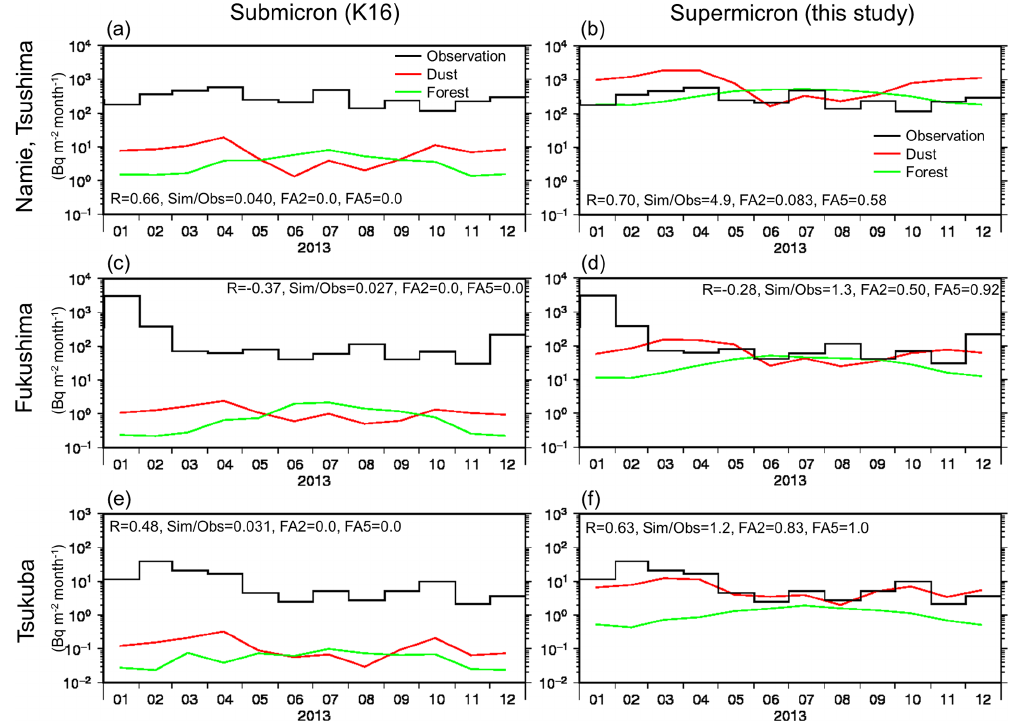
Figure 3. Monthly deposition amounts of (black) observed 137 Cs and simulated 137 Cs associated with (red) dust aerosols and (lime) forest aerosols at Namie (Tsushima), Fukushima, and Tsukuba (Bqm − 2 ). The simulation results assuming submicron particles (K16; E c and v d are 0.04 and 0.1 cms − 1 , respectively) and those assuming supermicron particles (this study; E c and v d are 0.4 and 10 cms − 1 , respectively) are shown on the left and right, respectively. The statistical measures, such as the correlation coefficient ( R ), simulation-to-observation median ratio (Sim / Obs), numerical fraction of data within a factor of 2 (FA2), and numerical fraction of data within a factor of 5 (FA5), between the observations and the simulations (dust plus forest) for each simulation result are embedded in each